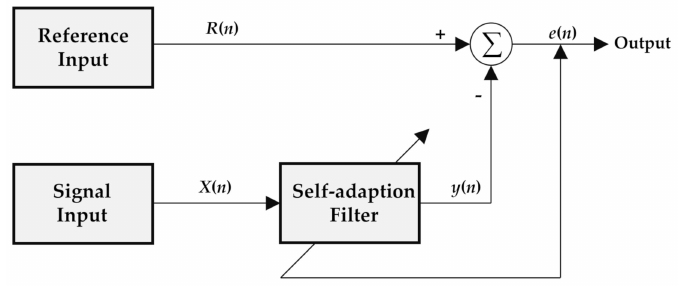
Figure 1. Block diagram of the adaptive filtering